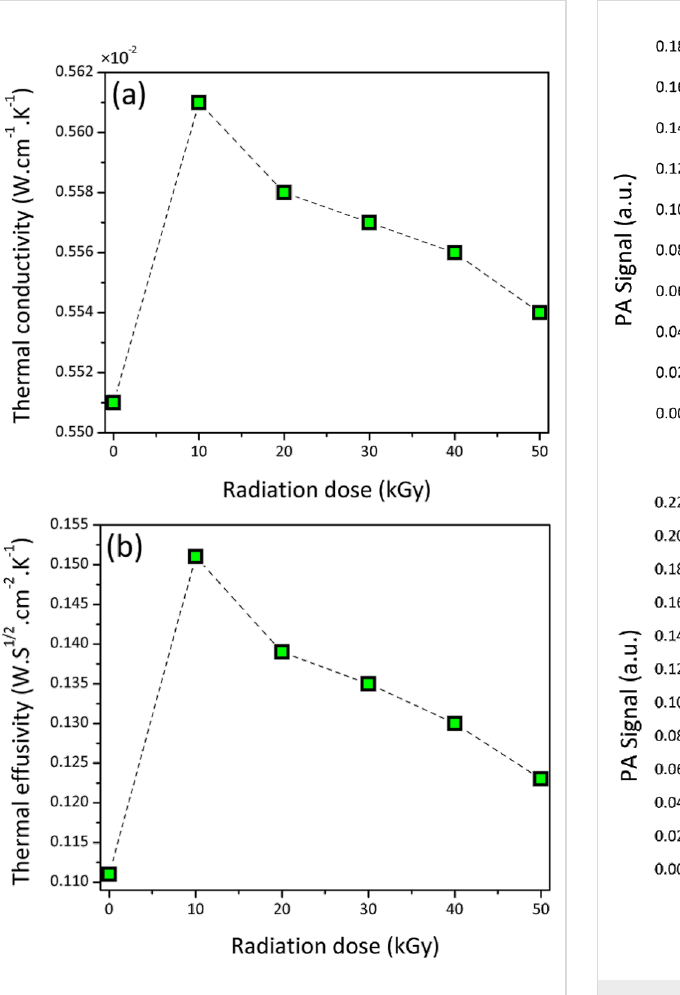
Figure 8: A typical PA signal as a modulation of frequency for (a) water and ethylene glycol, (b) ZnS–PVA nanofluids after irradiation with 50 kGy. The solid curve and hollow symbols indicate the theoreti- cal fitting and experimental data, respectively.